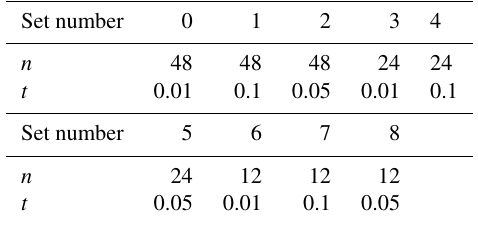
Table 1. Parameter sets used for the synthetic